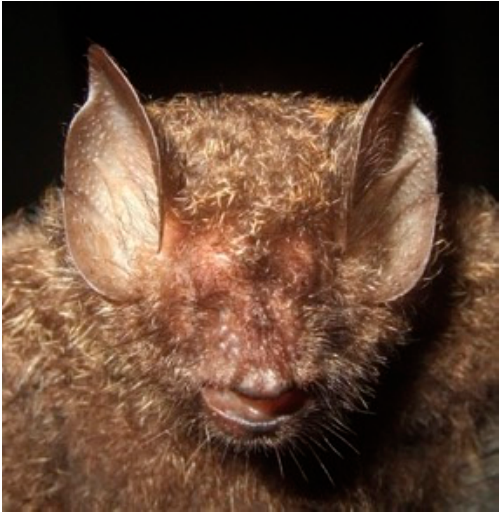
Figure 22. Phoniscus jagorii , adult female. Photograph by Vu Dinh Thong.